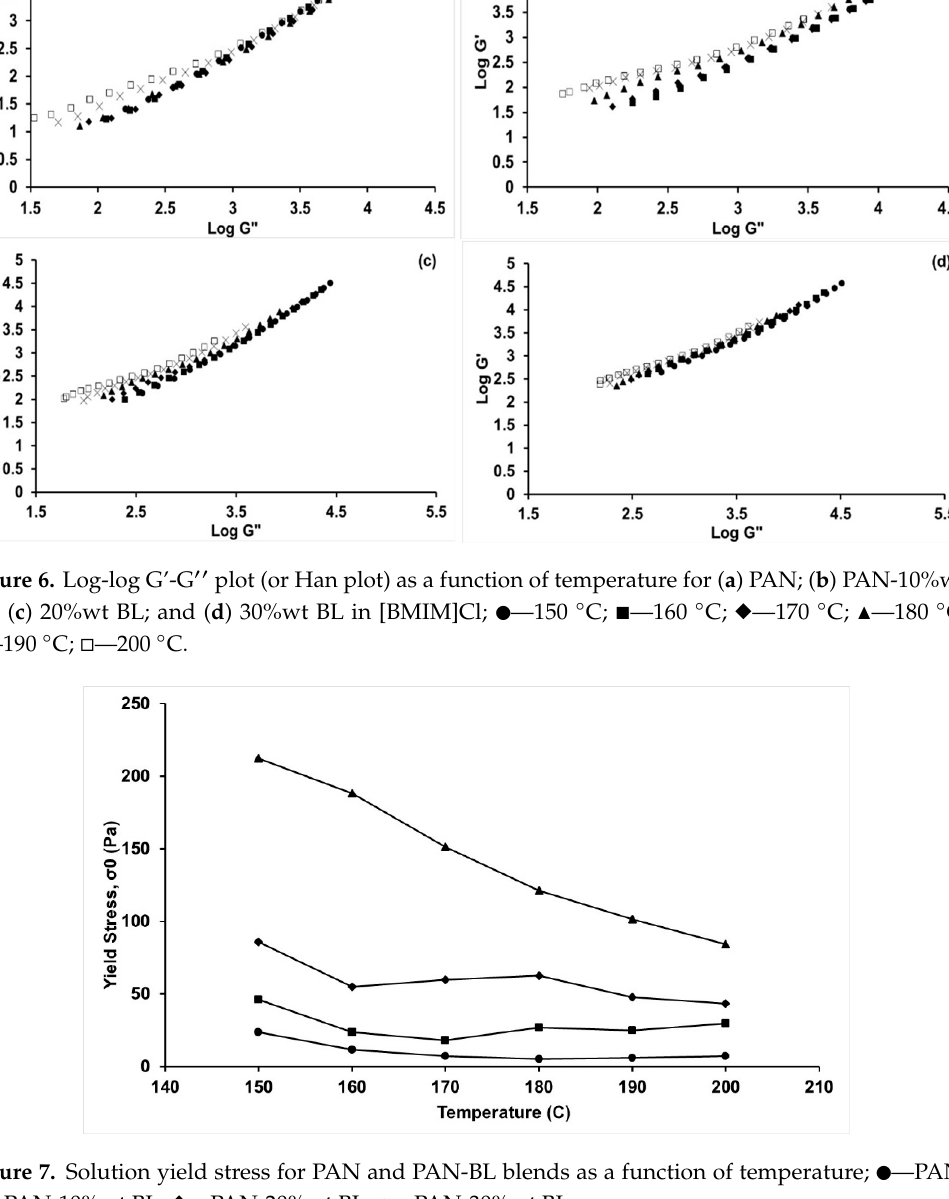
Figure 6. Log-log G’-G ′′ plot (or Han plot) as a function of temperature for ( a ) PAN; ( b ) PAN-10%wt BL; ( c ) 20%wt BL; and ( d ) 30%wt BL in [BMIM]Cl; ● —150 °C; ■ —160 °C;  —170 °C; ▲ —180 °C; X— 190 °C; □ —200 °C.